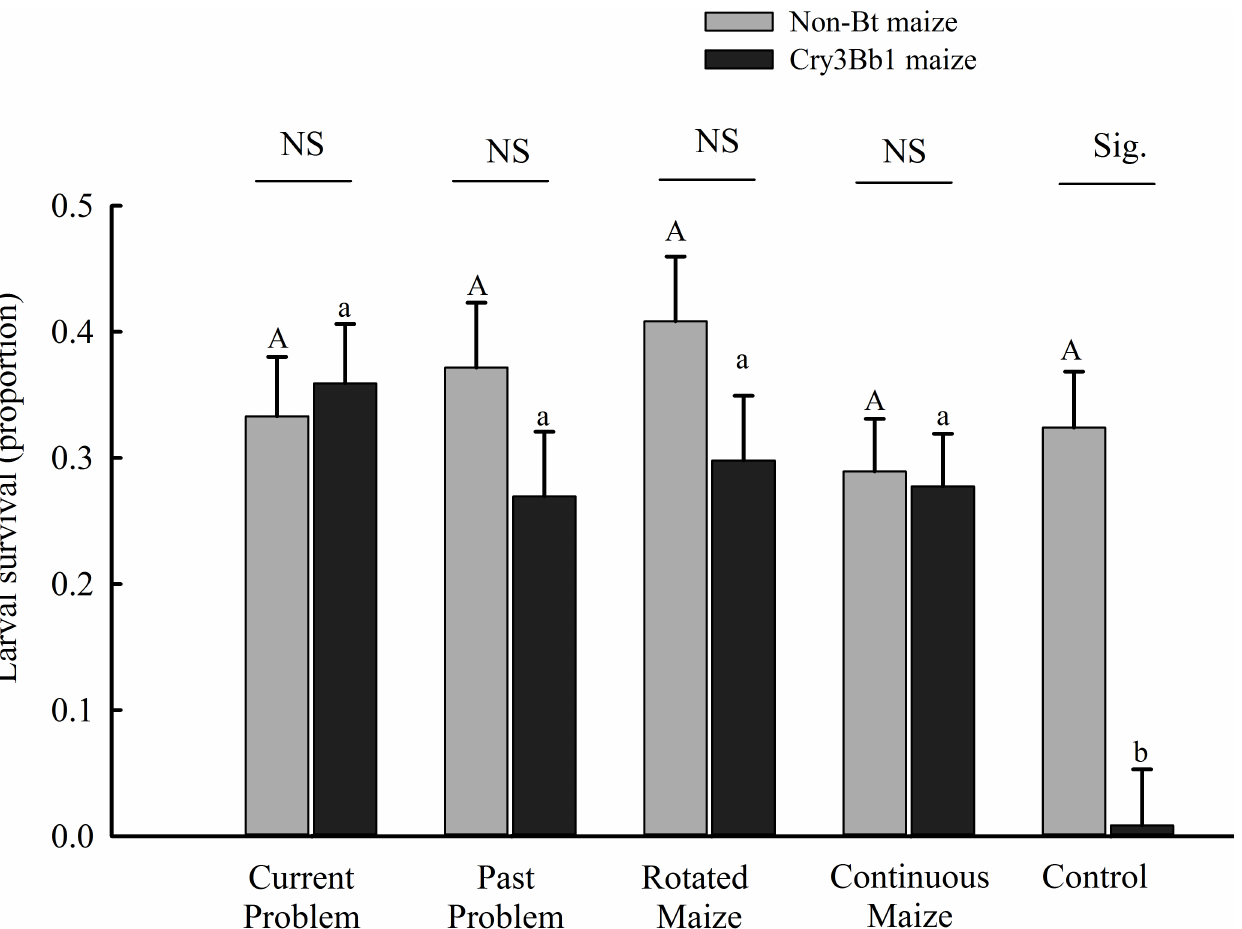
Fig 2. Survival of western corn rootworm larvae on Cry3Bb1 maize and non-Bt maize in plant-based bioassays. Bar heights are sample means and error bars are the standard error of the mean. Uppercase letters indicate significant differences between population classes on non-Bt maize and lowercase letters indicate significant differences between population classes on Cry3Bb1 maize. Differences between Cry3Bb1 maize and non-Bt maize within a population class are indicated by either NS for a non-significant difference or Sig., which stands for a significant difference.